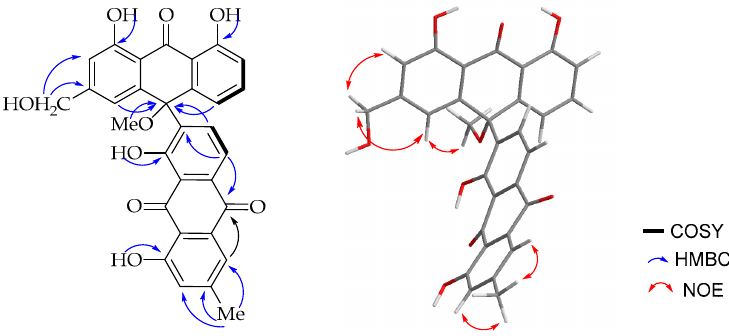
Figure 3. COSY (bold lines), key HMBC (blue arrows) and key NOE (red arrows) correlations of 3 . Compound 4 was obtained as a colourless solid. The ESI-MS ( m / z 625 (for [M + Na] + ) and HR-MS ( m / z 603.5395 (for [M + H] + ) along with the NMR data was compatible with the molecular formula C 37 H 62 O 6 . It has a UV absorption at λ max 213, 278 nm. Its IR spectrum indicated the presence of hydroxyl (3410 cm − 1 ) and conjugated carbonyl (1637 cm − 1 ) functionalities. The 1 H-NMR